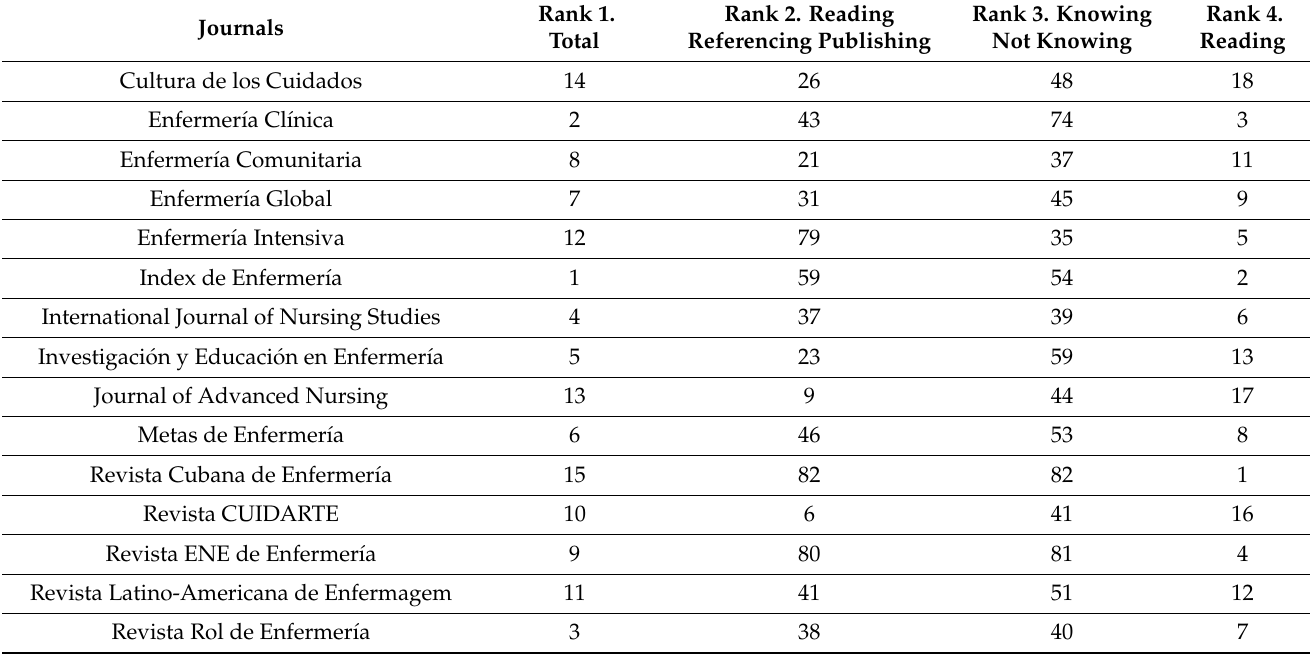
Table 5. Impact and variability indexes according to the reading, referencing, publishing in, knowing, and not knowing criteria of the top 15 journals in Spanish, Portuguese, and English. Rank 1. Rank 2. Reading Rank 3. Knowing Rank Journals Total Referencing Publishing Not Knowing